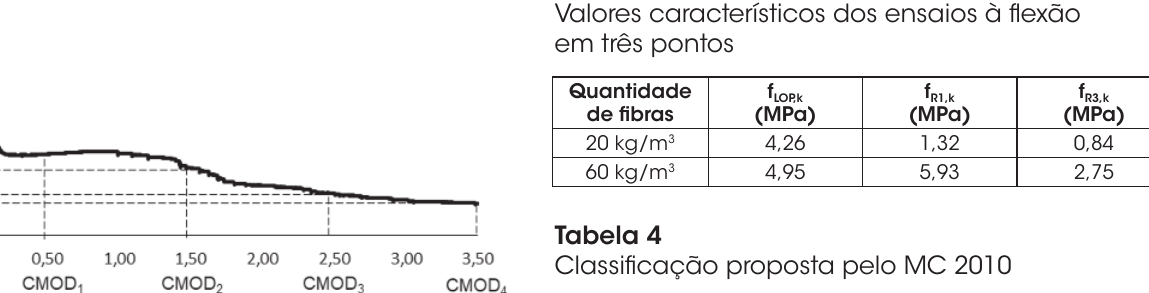
Valores experimentais das tensões residuais: f